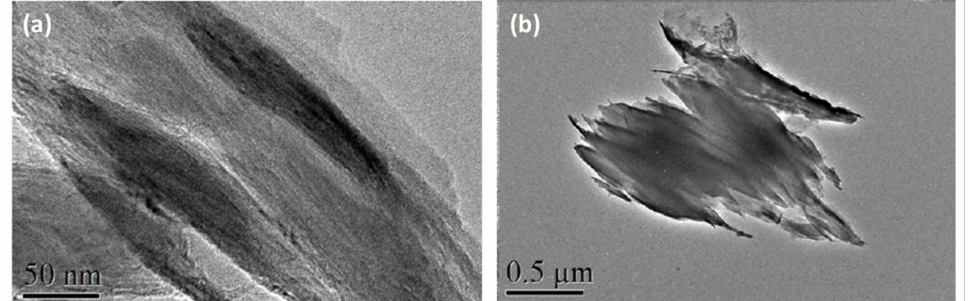
Figure 3. TEM images of exfoliated nanosheets on a carbon-copper